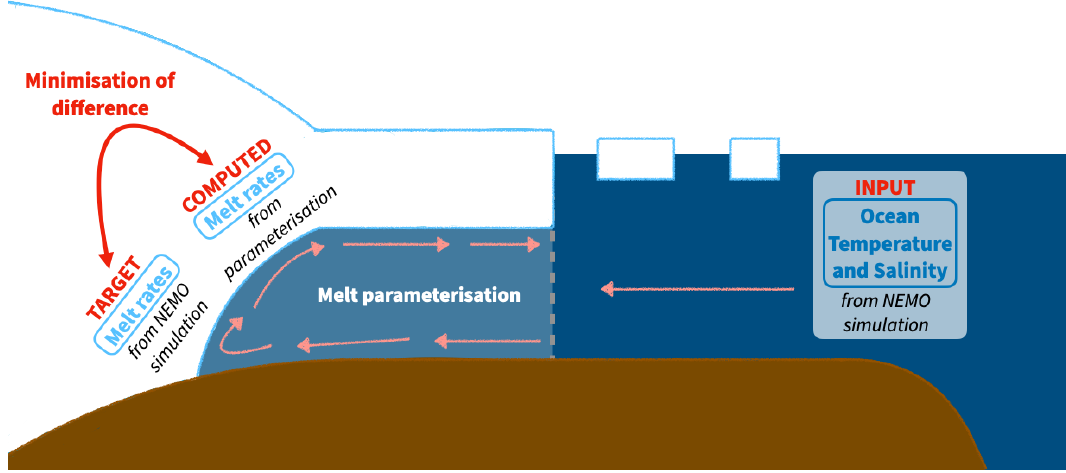
Figure 1. Schematic of the perfect-model approach to assess the different parameterisations.